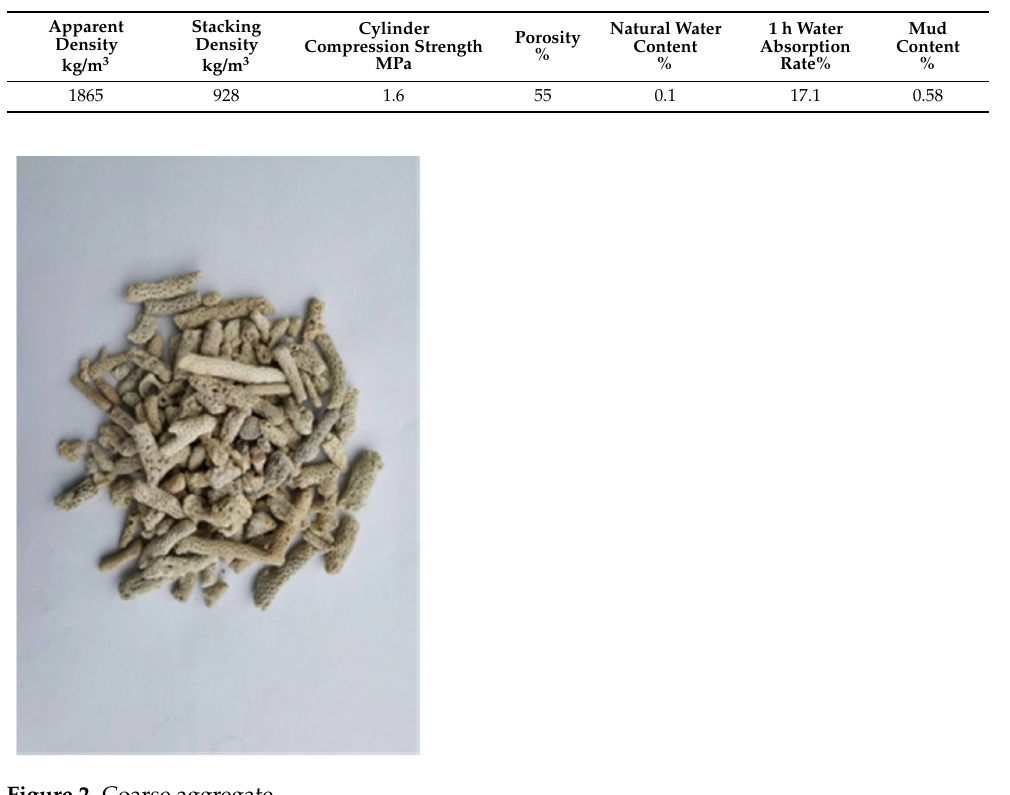
Figure 2. Coarse aggregate.